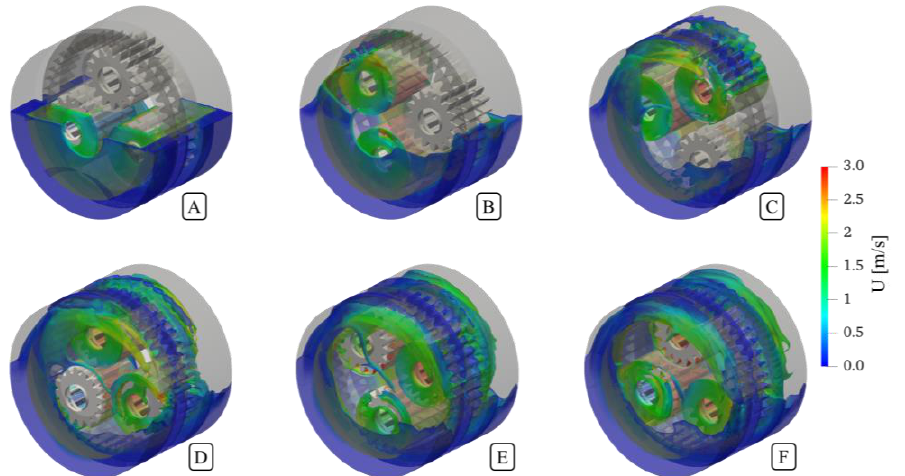
Figure 14. ( A – F ) evolution of the oil flow for the SIM-id2v3 operating condition at different timesteps during the planet carrier rotation. The oil is gradually brought to the other parts of the gearbox. The contact between the planets and the ring gears seems to be well lubricated. The rotatory motion of the oil flow gives origin to oil rings around the planet carrier and the planets.